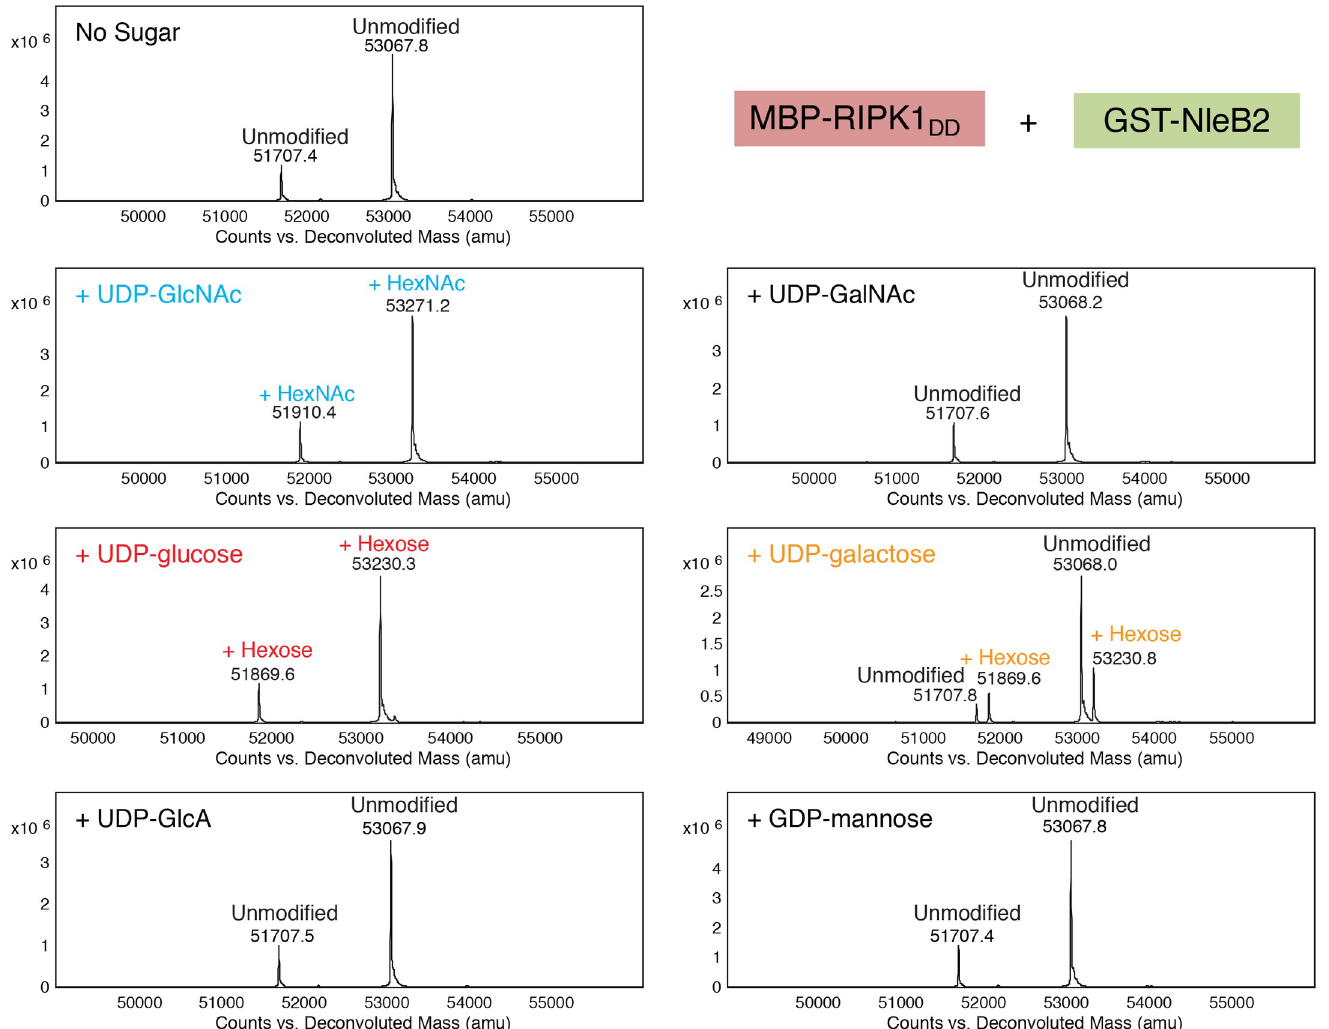
Fig 3. Utilization of UDP-GlcNAc, UDP-glucose and UDP-galactose by NleB2. Deconvoluted intact mass spectra of MBP-RIPK1 DD proteoforms (full-length expected average mass 53081 Da) incubated with GST-NleB2 either without sugar donors, or in the presence of one of UDP-GlcNAc, UDP-glucose, UDP-GalNAc, UDP-galactose, UDP-glucuronic acid or GDP-mannose at 50 μ M.